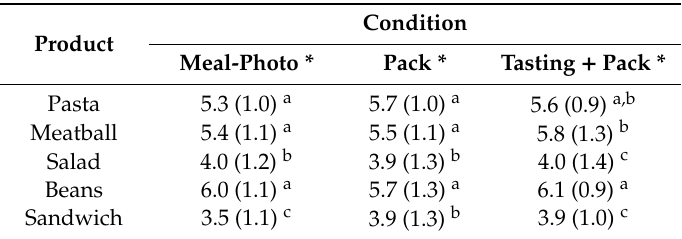
Table 4. Expected satiety mean values, and standard deviation in parenthesis, of the five products evaluated on a plate (Meal-Photo condition), in the pack (Pack Alone condition) and after tasting with the packaging in view (Tasting-Pack alone